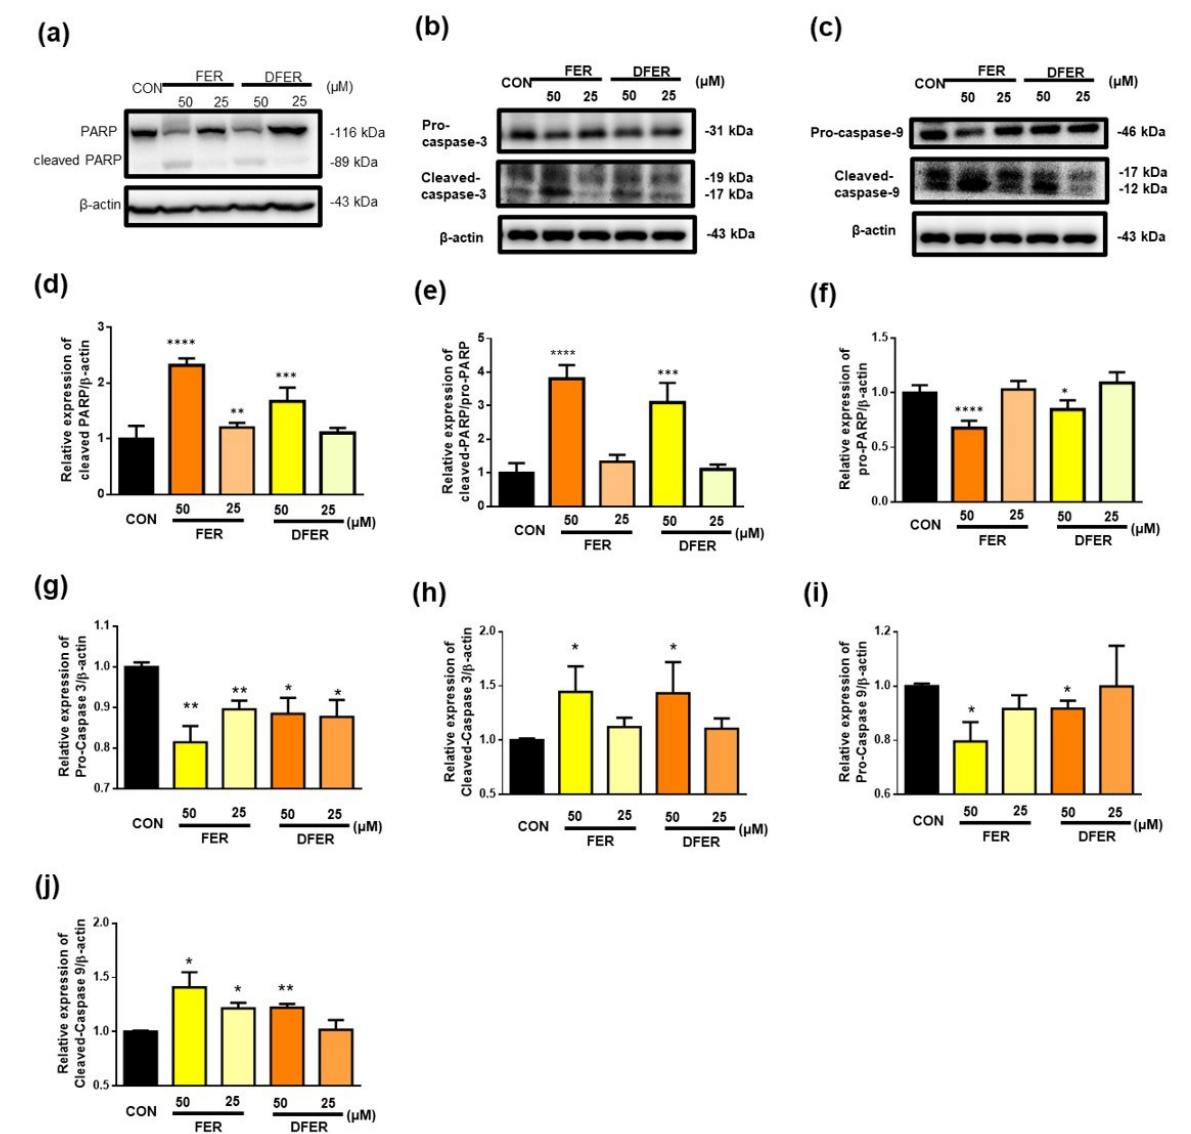
Figure 7. Treatment with FER and DFER for 24 h may induce cell apoptosis via the intrinsic pathway. Representative protein expressions of both ( a ) PARP and cleaved PARP, ( b ) caspase-3 and cleaved caspase-3, ( c ) caspase-9 and cleaved caspase-9, and quantification of Western blotting of ( d – f ) PARP ( g , h ) caspase-3 and ( i , j ) caspase-9 by using β-actin as internal control. Symbols (*), (**), (***) and (****) indicate significant differences ( p < 0.05), ( p < 0.01), ( p < 0.005) and ( p < 0.001), respectively, analyzed by using Student’s t -test, as compared to the control